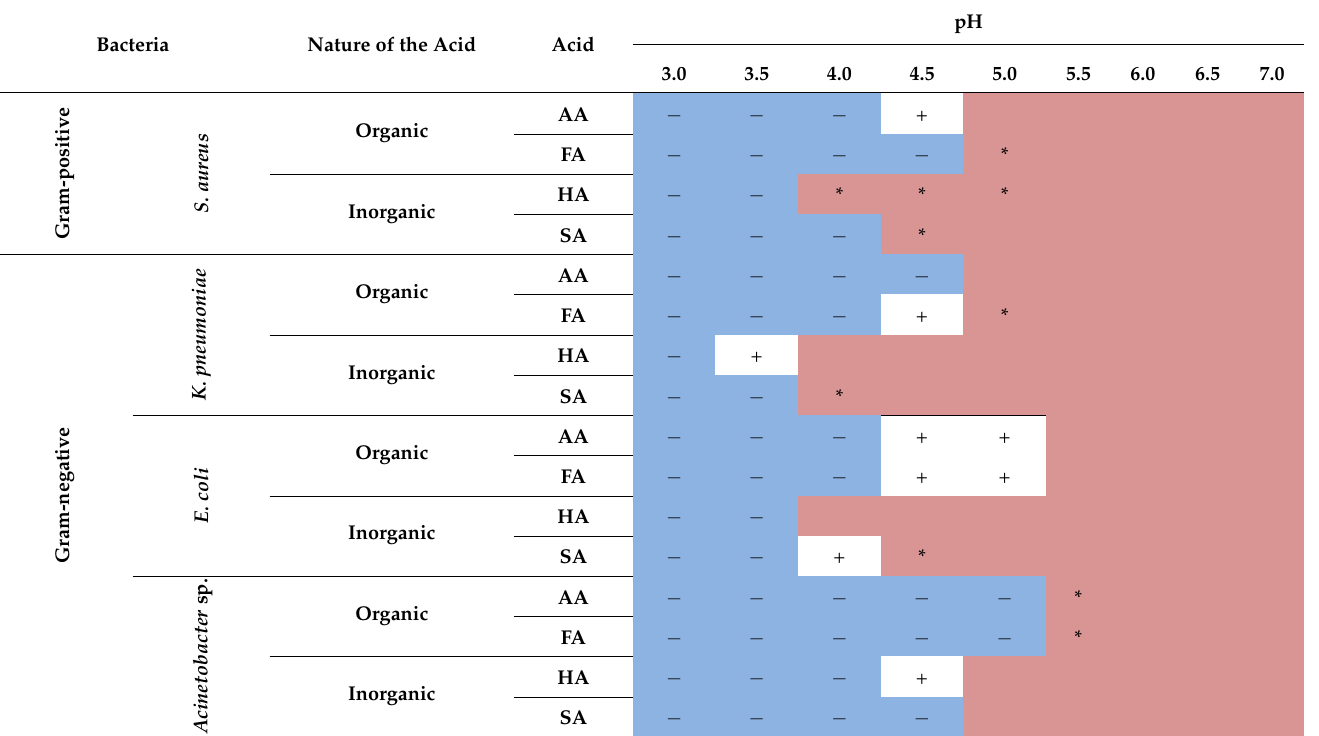
Table 1. Bacterial tolerance to